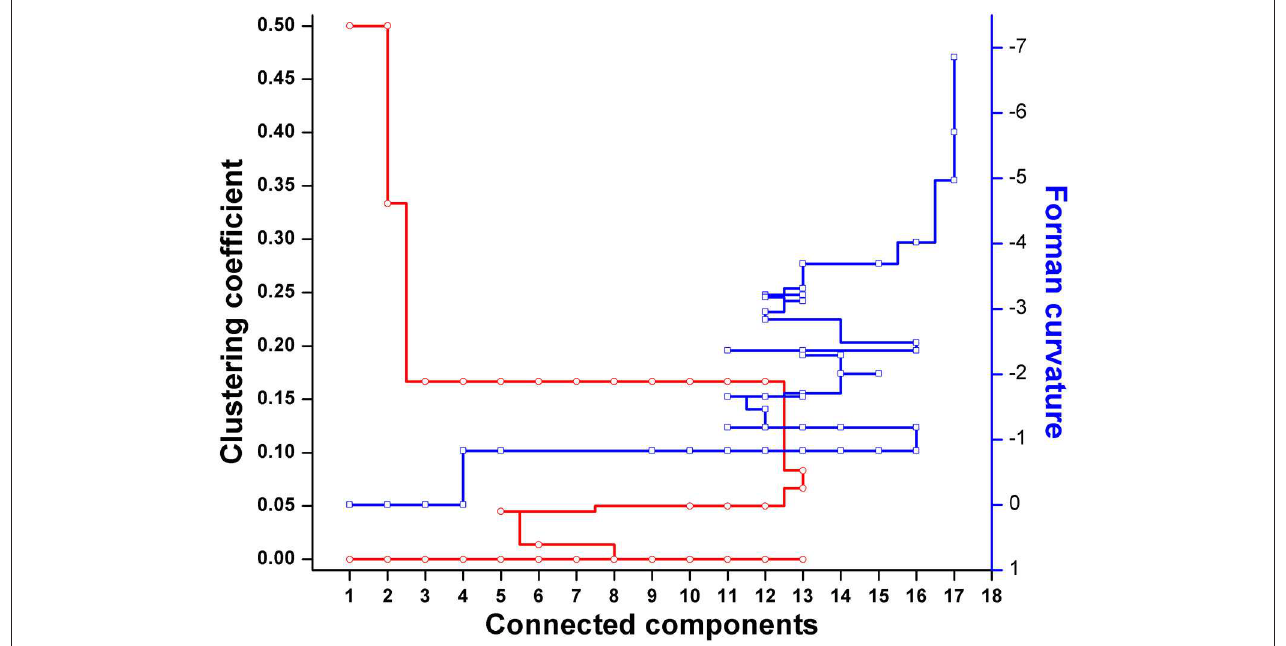
FIGURE 8 | Robustness analysis of the Master model (M) using nodes deletion on the basis of Forman and Forman-Ricci curvature, or clustering coefficient.